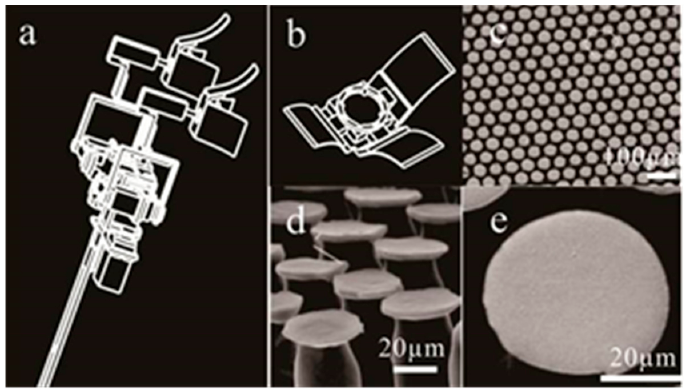
Figure 1. Structural hierarchy of the biologically inspired robot adhesive system. ( a ) Gecko-inspired robot; ( b ) Footpad of the robot; ( c – e ) Biomimetic mushroom-shaped adhesive microstructure (MSAMS) made of PVS (reproduced with permission from [10]. Copyright the Royal Society,